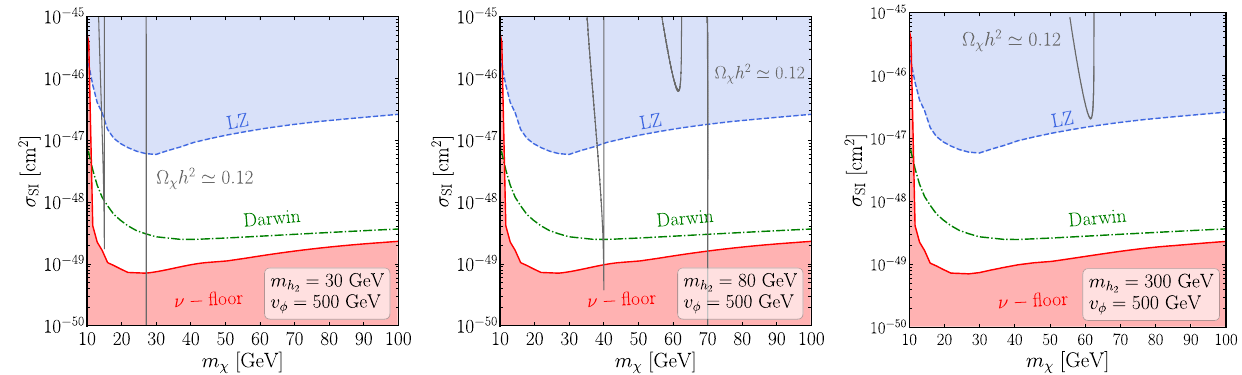
Fig. 7 As in Fig. 5 for the singlet portal DM scenario for different values of the mass of the additional scalar m h selected value of v φ and m h as dark-grey lines. 17 In Fig. 7 2 the resonances correspond to DM annihilating via (quasi) on- shell mediators ( h 1 and h 2 ) and therefore are peaked around / 2 (cid:7) 62 . 5 GeV and m χ (cid:7) m / 2. The vertical m χ (cid:7) m h h 2 1 lines at m χ (cid:7) 30 GeV in the left plot and m χ (cid:7) 80 GeV